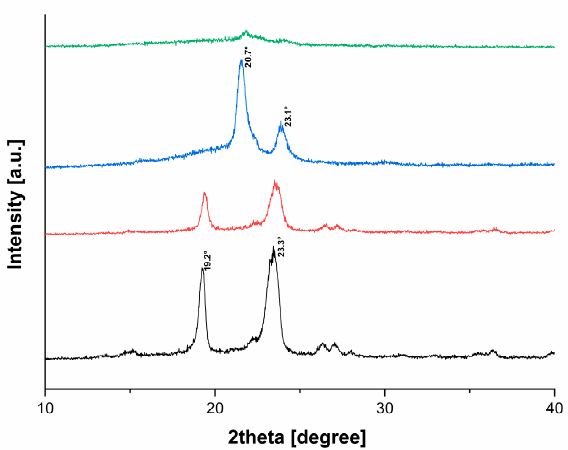
Figure 4. XRD shows the diffraction peaks of PEO powder (black), PEO extrudate (red), PCL powder (blue) and PCL extrudate (green).